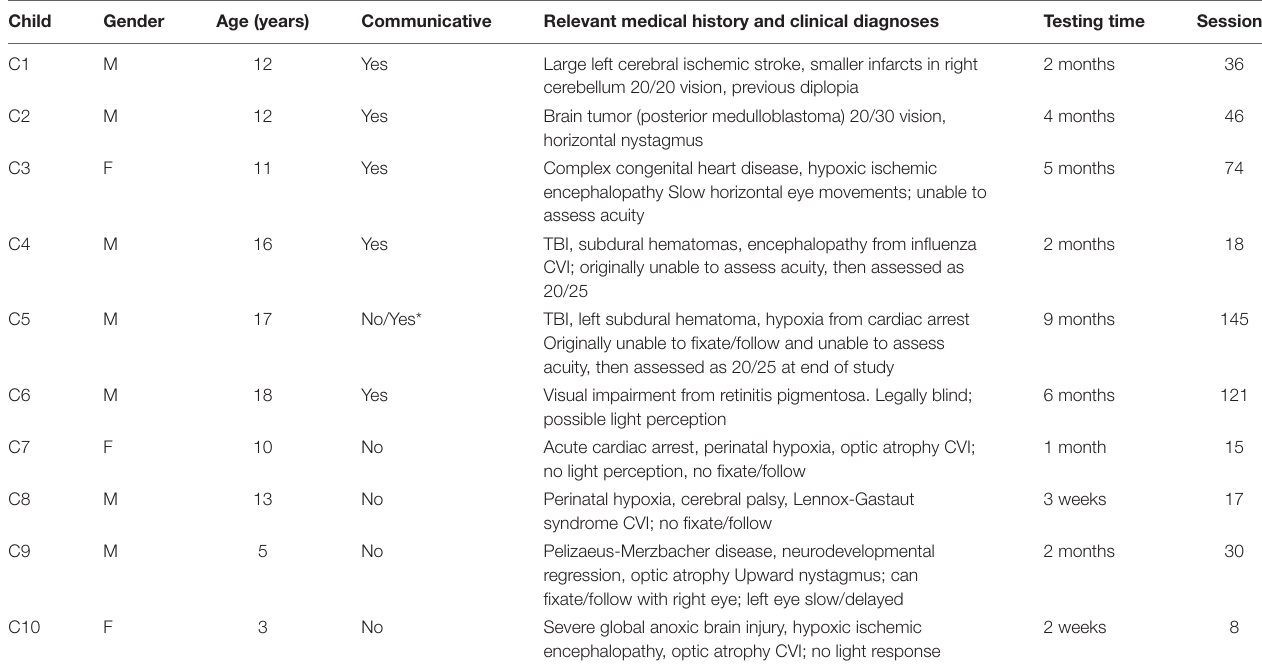
FIGURE 3 | Radial plots of mean saccade amplitude. As in Figure 2 , saccades in the Bubble Burst task were binned into eight directions. The radius of each sector represents the mean amplitude of all saccades falling in that directional bin. The overall mean amplitude for each child in degrees of visual arc is denoted by the dotted blue ring, and the color of each sector changes gradually from blue to red as the mean amplitude for that direction exceeds the overall mean. The lighter ring segments at the end of each sector represent the standard error of mean amplitude in that direction. TABLE 1 | Participant